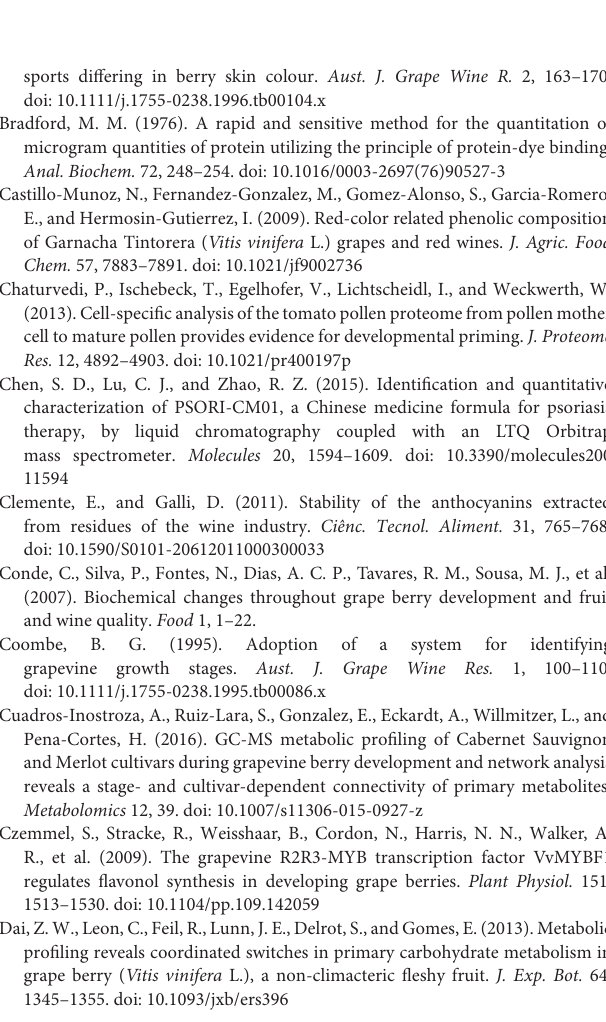
Table S1 | Metabolite information. Table S2 | Absolute quantification of 29 metabolite candidates. Table S3 | Protein sequencing information. Table S4 | NSAFs, ANOVA, BLAST results of protein candidates. Table S5 | Loading scores. Table S6 | K-means clustering analysis (12 clusters). Table S7 | Granger causality analysis of the integrated metabolomic and proteomic data sets. Table S8 | Anthocyanin profiles of grape berries of different cultivars. Figure S1 | Relative abundance of anthocyanins in mature berries (EL 38). Figure S2 | Hierachical bi-clustering analysis of protein candidates. Figure S3 | K-means clustering analysis of the integrated dataset. Figure S4 | Granger causality based